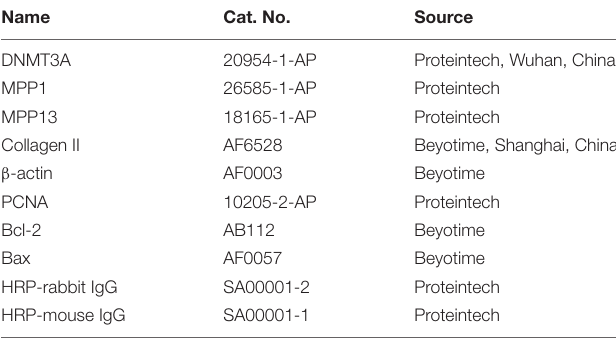
TABLE 3 | The antibodies used in Western